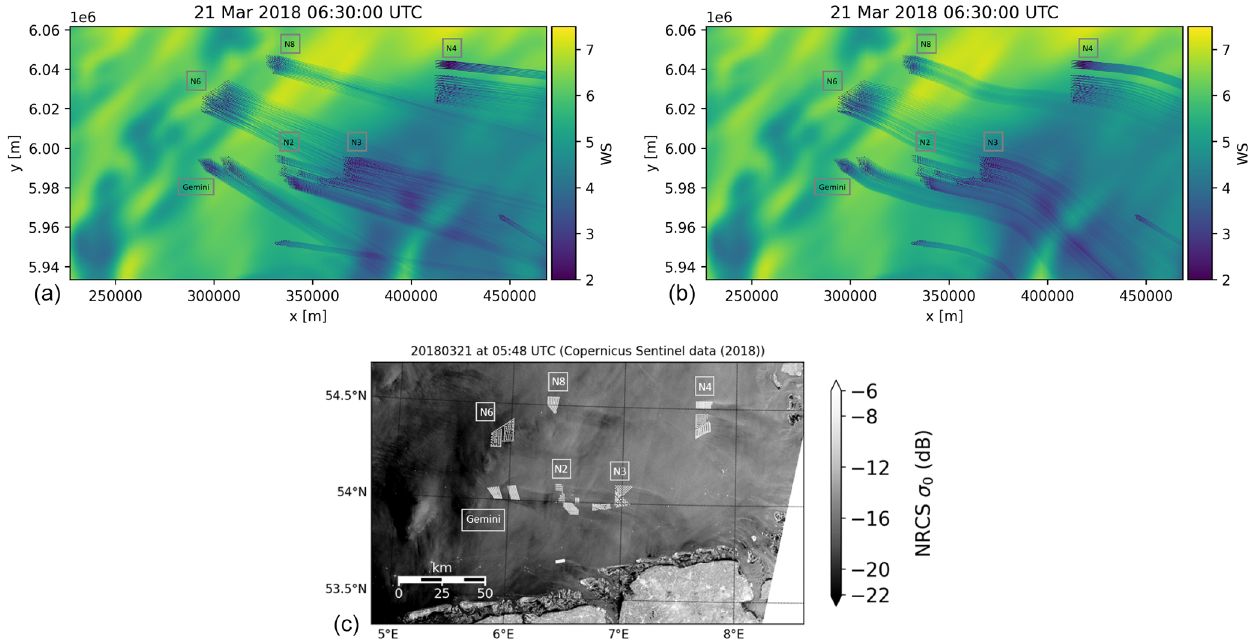
Figure 9. (a, b) Wind speed [ms − 1 ] at hub height in the German Bight for 21 March 2018 at 06:30:00UTC, simulated with flappy for all wind farms commissioned to that date. (a) Baseline model with straight wake propagation and (b) the new streamline wake model. (c) SAR image from Copernicus Sentinel data (ESA 2000–2020) showing cluster wakes in the German Bight on 21 March 2018 at 05:48:00UTC. The white dots show the wind turbines and the shading the backscatter value σ 0 of the normalized radar cross-section (NRCS).